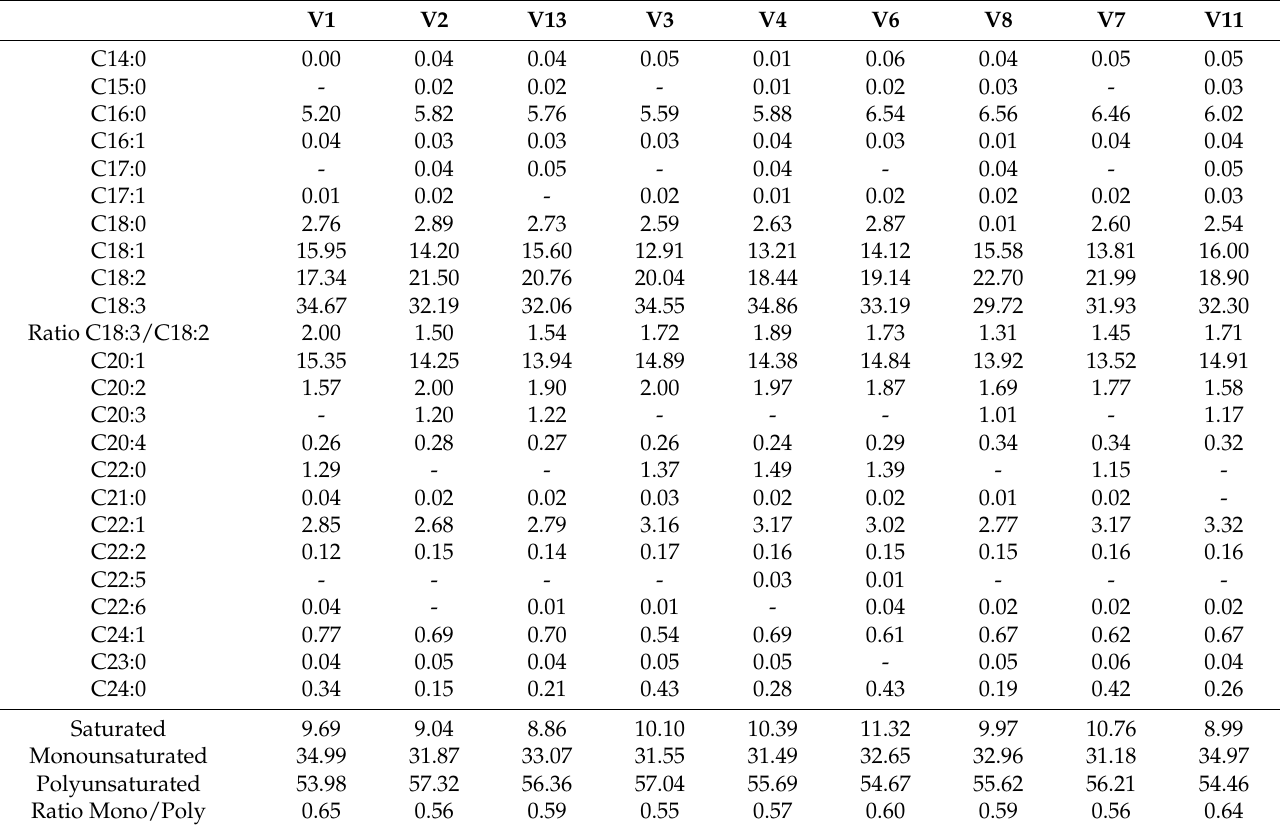
Table 2. Fatty acid content (% based on dry seed mass) of camelina seeds varieties in the